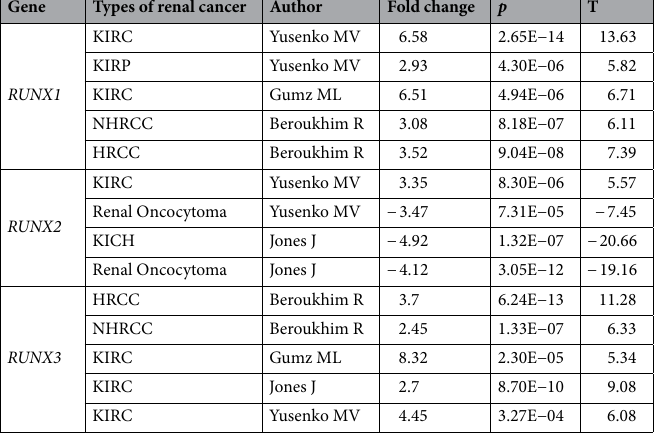
Table 1. Differential expression level analysis of RUNX genes in different types of kidney cancer. KIRC kidney renal clear cell carcinoma, KIRP kidney renal papillary cell carcinoma, NHRCC non-hereditary renal clear